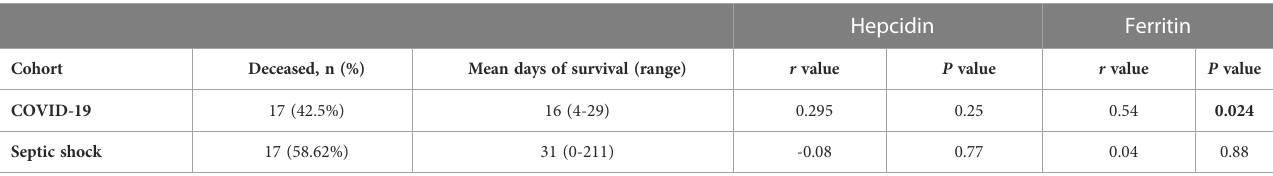
TABLE 3 Correlation between TP1 hepcidin or ferritin levels and days survived by deceased infectious disease